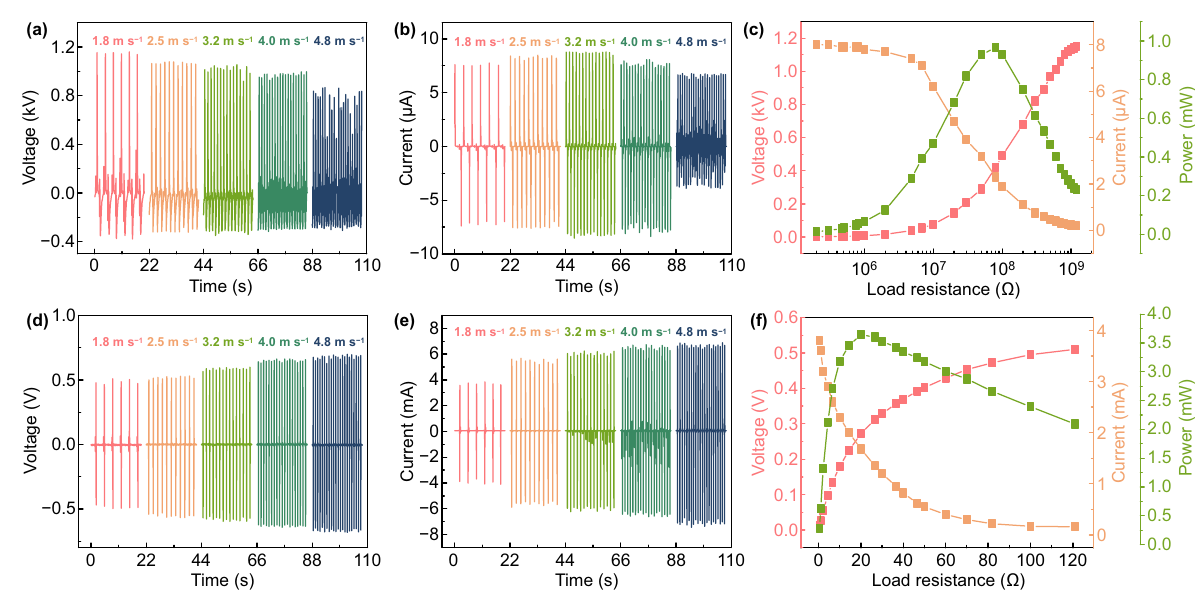
Fig. 4 Electrical output performance of the W-HNG. The V oc and I sc of an individual TENG ( a , b ) and EMG ( d , e ) at wind speed ranging from 1.8 m s −1 to 4.8 m s −1 . V oc , I sc , and power dependence of the external load resistance of the TENG c and EMG f at a wind speed of 1.8 m s